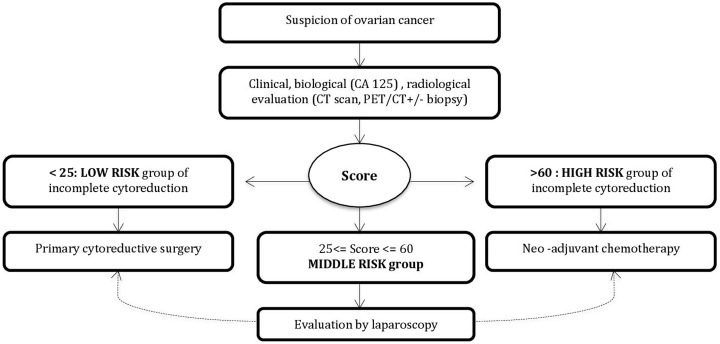
Decision algorithm.